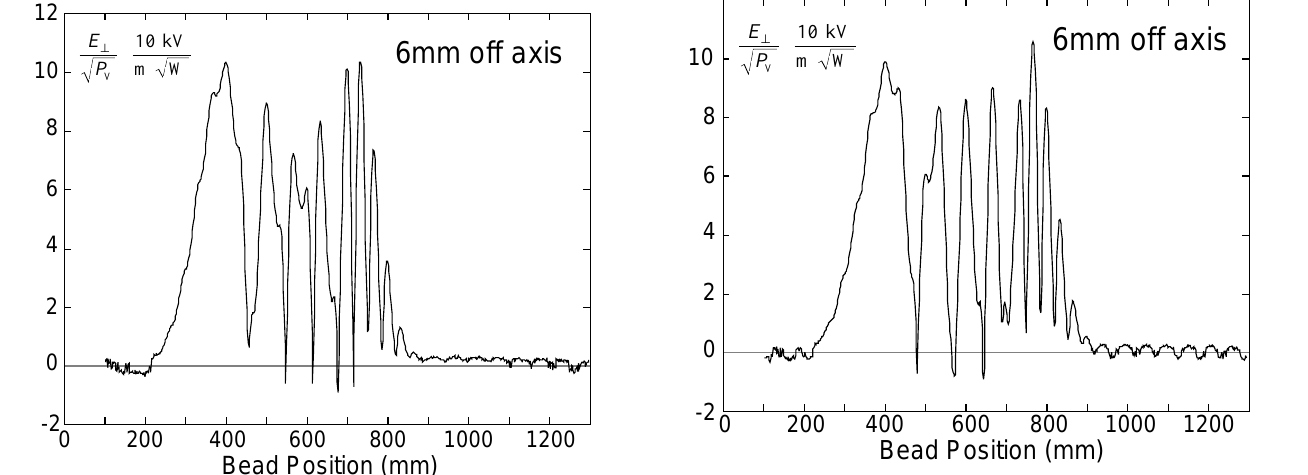
FIG. 7. Measurement: transverse (cid:69) field of mode #15. transverse (cid:69) field of the same mode. All fields were mea- sured with a transverse offset (here 6 mm off axis), since on axis.